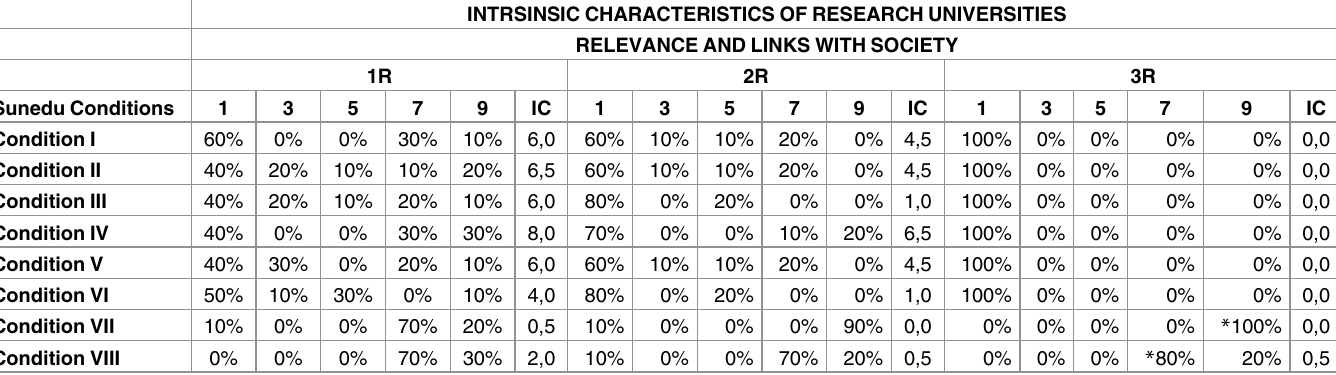
Table 4. Results of the Sunedu-Relevance & links with society conditions.